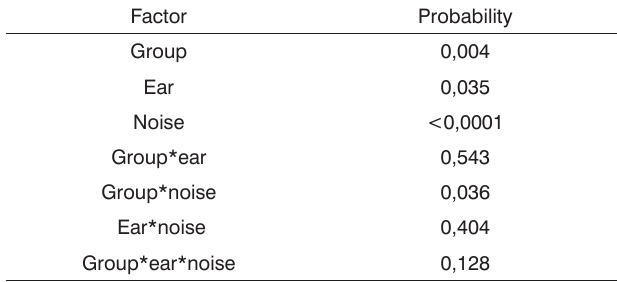
Table 2. Results of analysis of variance with repeated measures for each factor